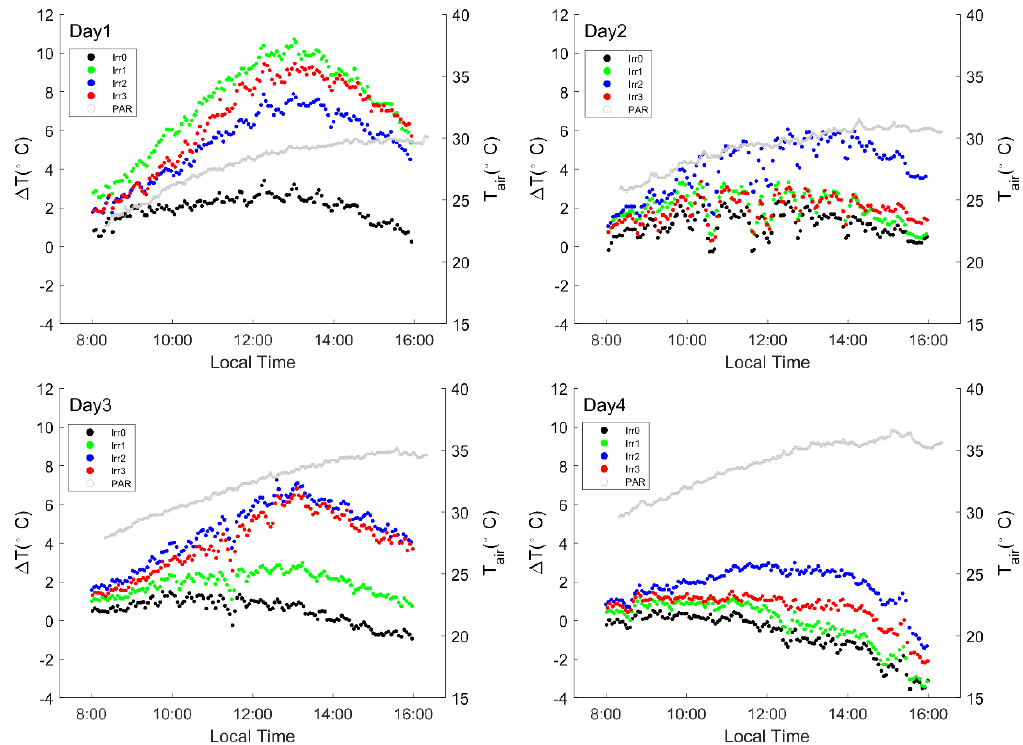
Figure 5. Differences between diurnal variations in canopy temperature and air temperature ( ∆ T)